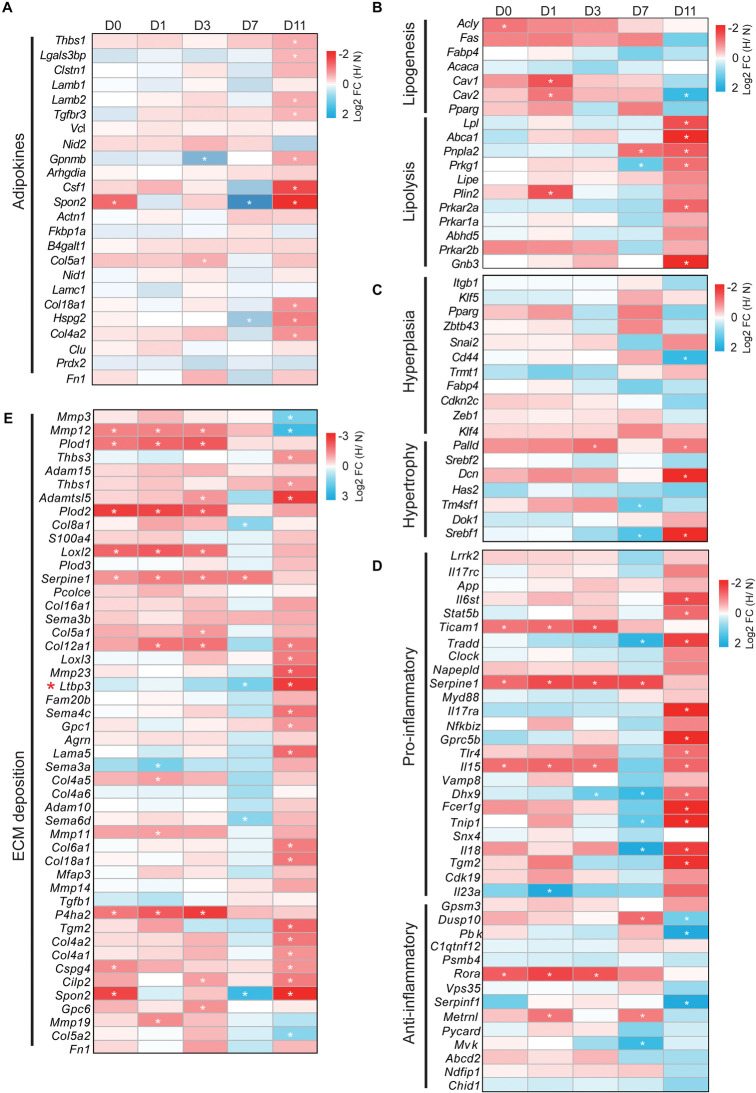
Hypoxia differentially modulates the expression profiles of adipose-associated genes. Genes associated with (A) adipokines, (B) lipogenesis and lipolysis, (C) hyperplasia and hypertrophy, (D) pro-inflammation and anti-inflammation, and (E) ECM modulated by hypoxia. Expression profiling of these genes is presented as heatmaps [log2 fold change (hypoxia/normoxia)]. Corresponding box plots represent the overall expression change of these genes at each timepoint (Supplementary Figure S1). *p < 0.05, **p < 0.01. H, hypoxia; N, normoxia. The gene (Ltbp3) marked by red star mentioned in “Discussion” section.